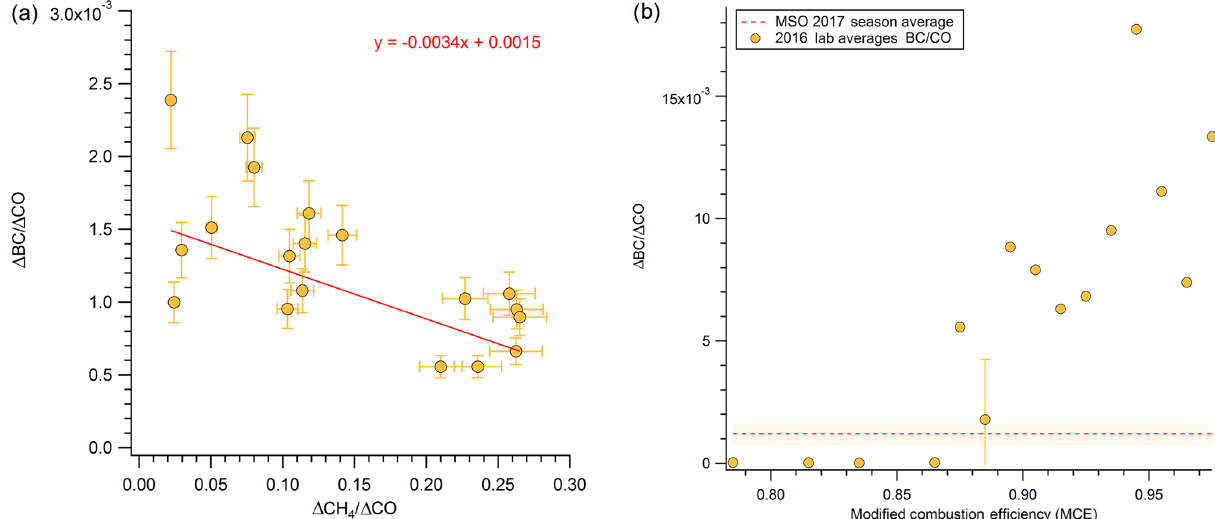
Figure 2. (a) Methane emission ratio versus black carbon emission ratio. Point shown are for events that have both a CH 4 / CO ratio and a BC / CO ratio. (b) Lab average (Selimovic et al., 2018) BC / CO ratio versus modified combustion efficiency (MCE), separated into bins by 0.01 of